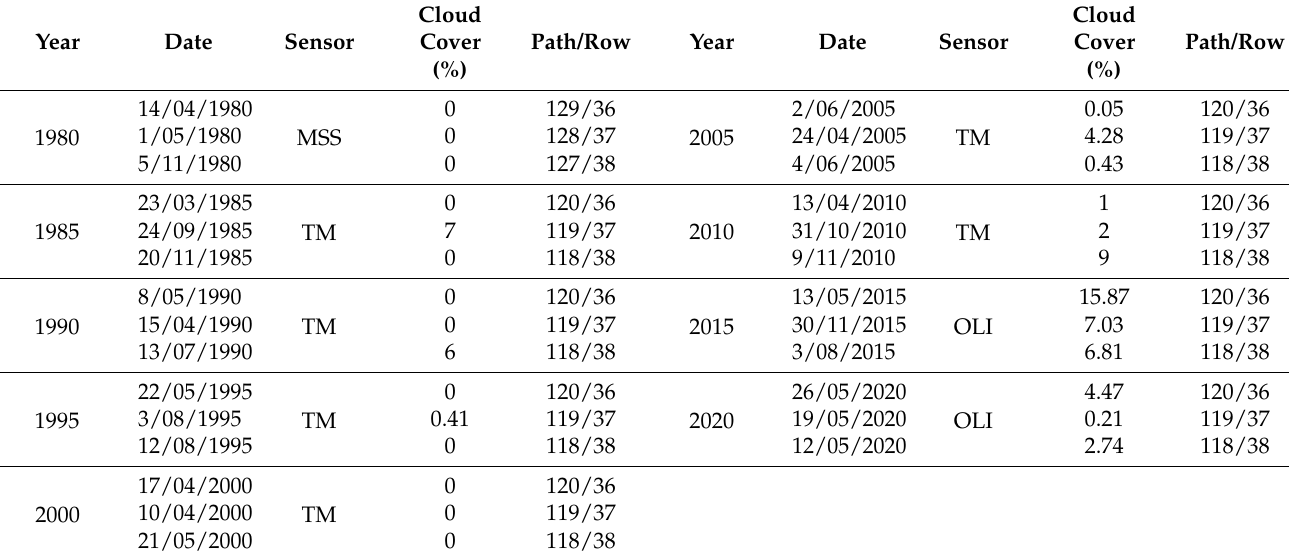
Table 1. The list of Landsat images in this study between 1980 and 2020.